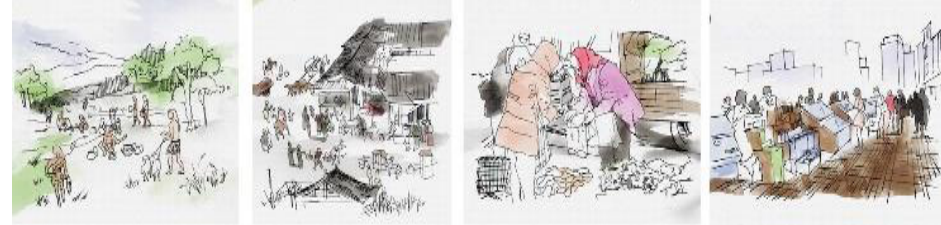
Figure 1. Traditional Fair’s Evolution (Source: Own drawing).